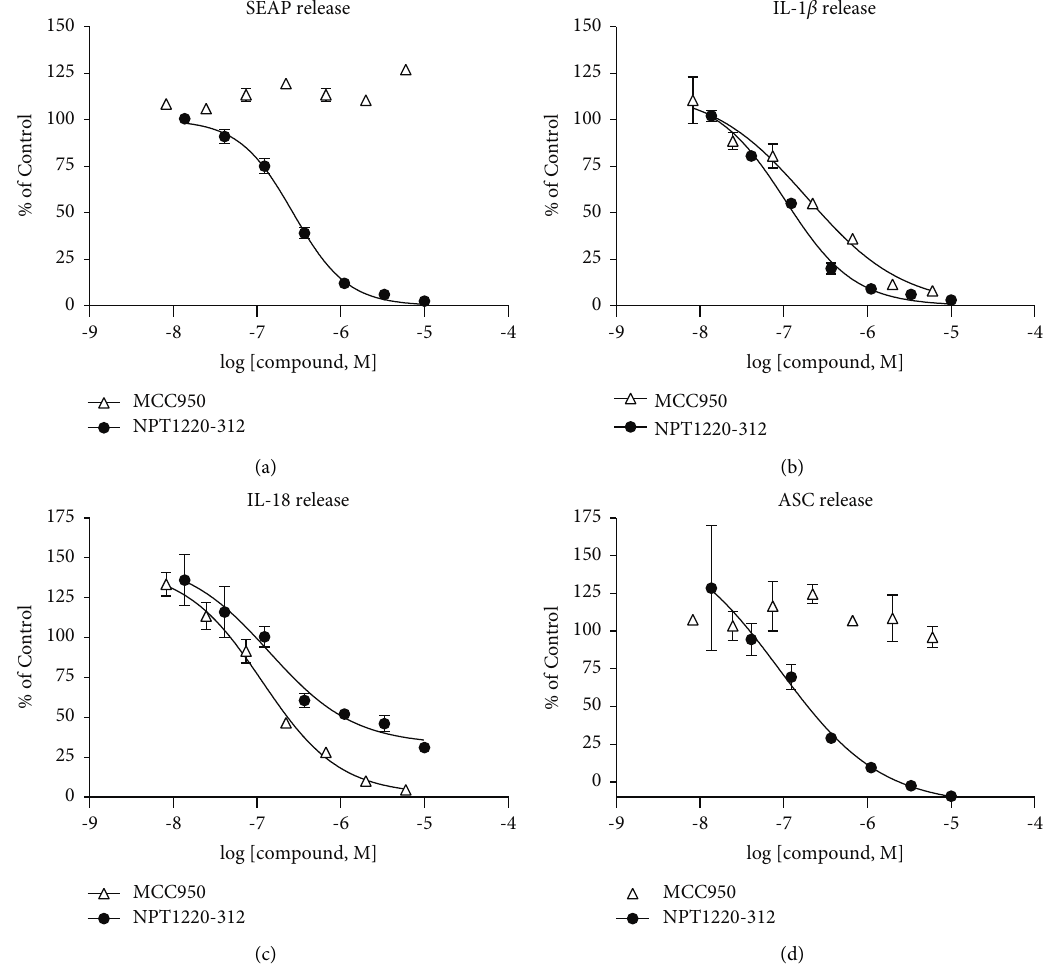
Figure 5: NPT1220-312 blocks TLR2-mediated secretion of inflammasome markers. The NLRP3 inflammasome in THP1 cells differ- entiated to macrophages was primed with 1.5ng/ml of Pam 3 CSK 4 and then activated with 100 μ g/ml monosodium urate (MSU): (a) NPT1220-312 but not MCC950 blocked Pam 3 CSK 4 -evoked release of SEAP. (b) Both MCC950 and NPT1220-312 blocked IL-1 β release. (c) Both MCC950 and NPT1220-312 blocked IL-18 release. (d) NPT1220-312 but not MCC950 blocked Pam 3 CSK 4 -evoked release of ASC.